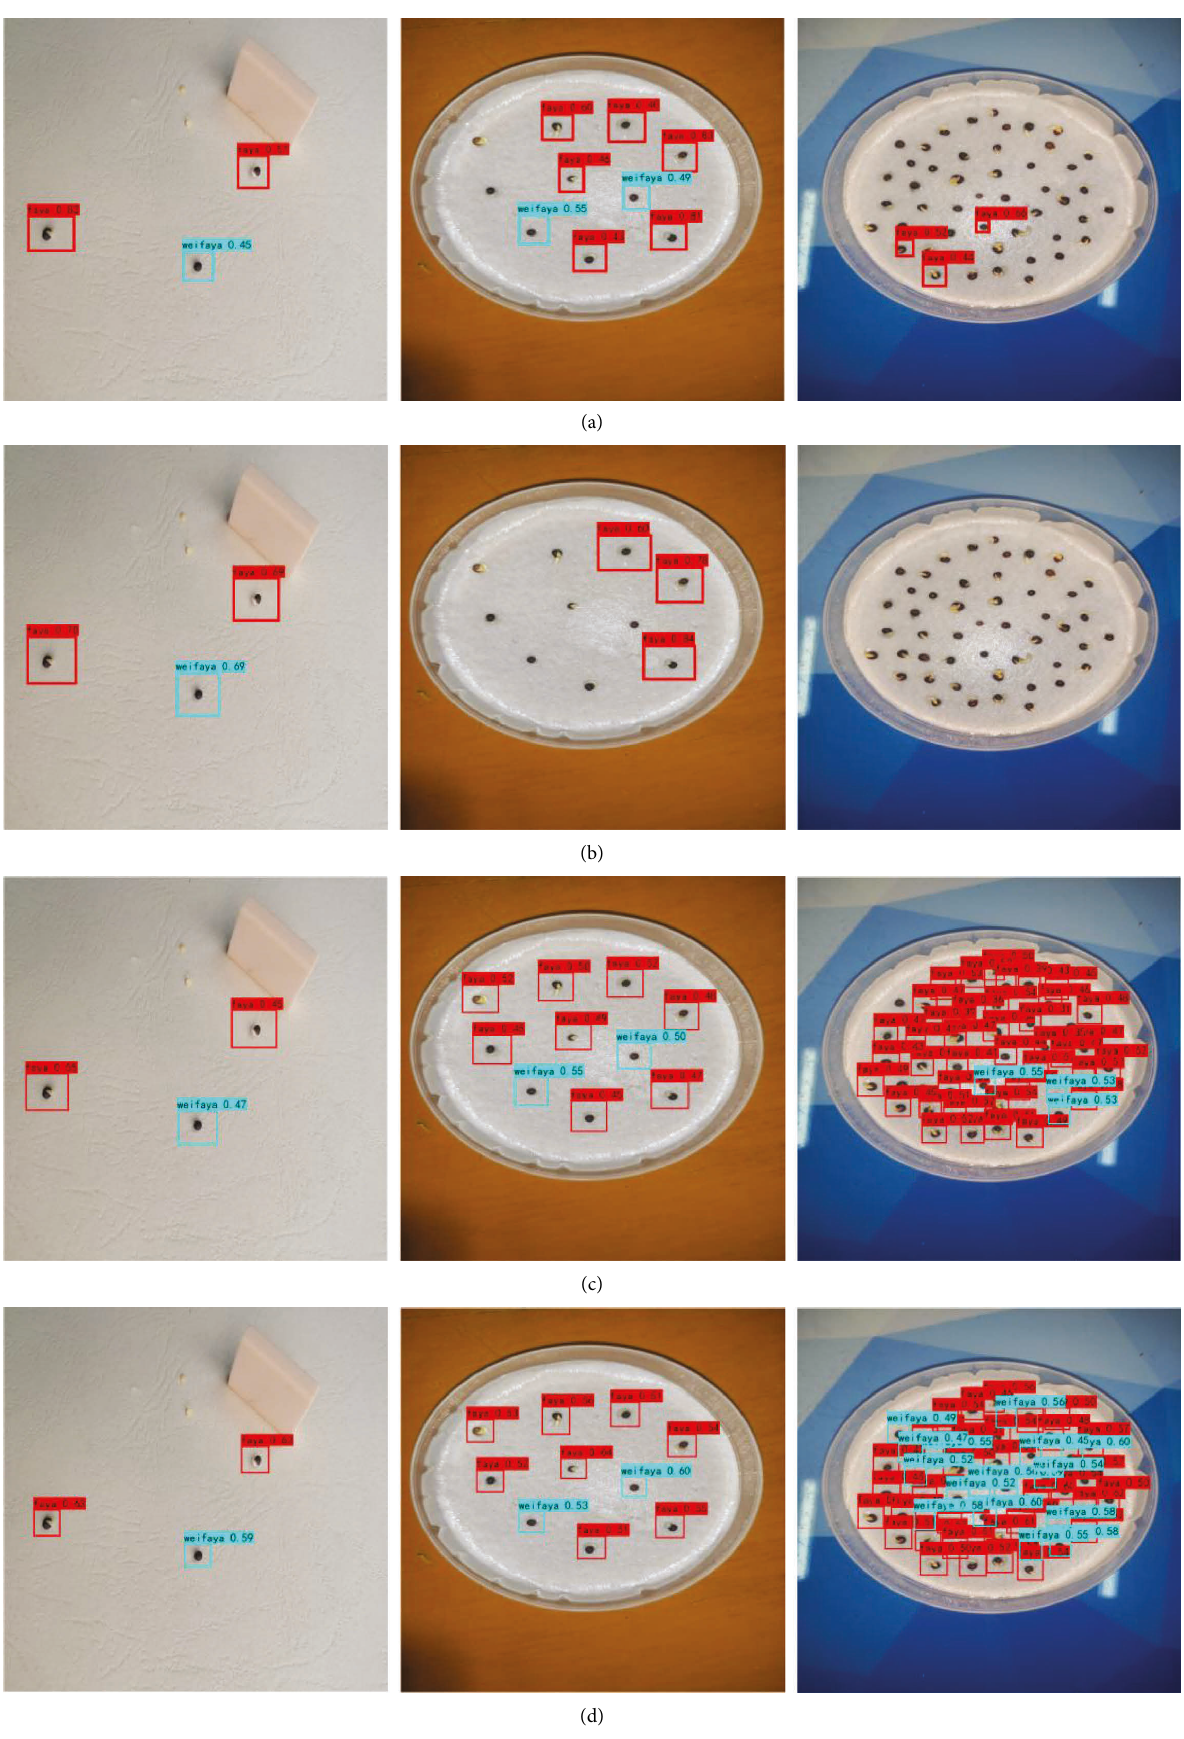
Figure 12: Detection results of different algorithms at different levels of density. (a) The detection results of Faster RCNN. (b) The detection results of SSD. (c) The detection results of CenterNet. (d) The detection results of DDST-CenterNet proposed in this